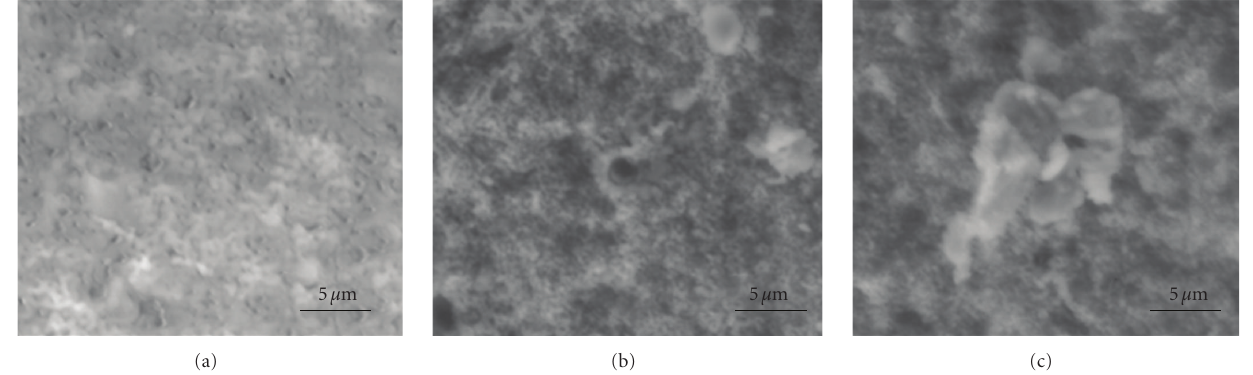
Figure 9: SEM micrographs of M x FA samples sintered at 950 ◦ C for 1h: (a) x = 0, (b) x = 1, and (c) x = 2.